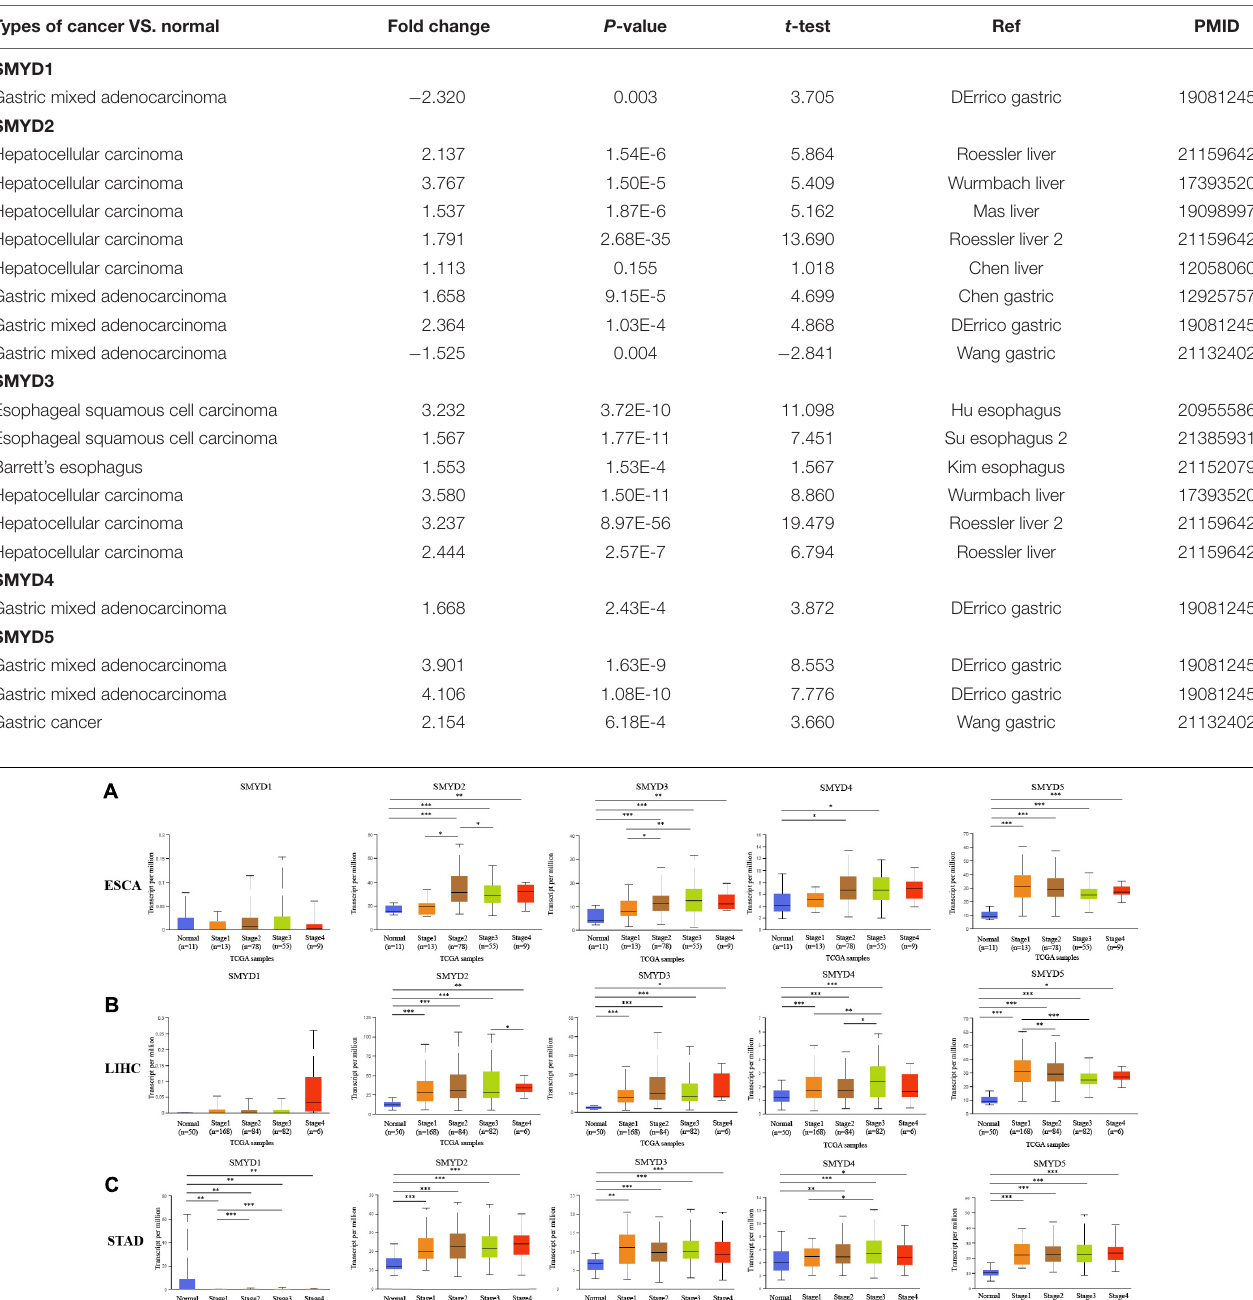
TABLE 1 | Significant changes of mRNA expression levels of SMYD family members in ESCA, LIHC, STAD, and normal tissues of esophagus, liver, and stomach (Oncomine). Types of cancer VS. normal